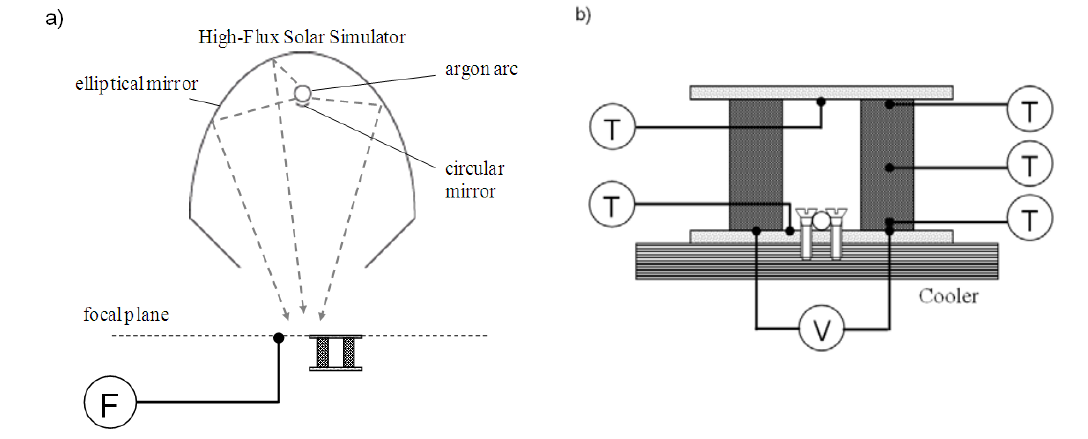
Figure 2. Schematic of the experimental setup at ETH’s High Flux Solar Simulator. (a) the TEC module is placed at HFSS’s focal plane; incident solar radiative fluxes measured by a thermogage (F). (b) position of type-K thermocouples (T) used to measure temperatures of the plates and of the hot end, middle, and cold end of the legs; terminals (V) provided at the cold ends for measuring the voltage/power output of the module. The cold plate was attached to a water-circuit cooler (denoted by screw